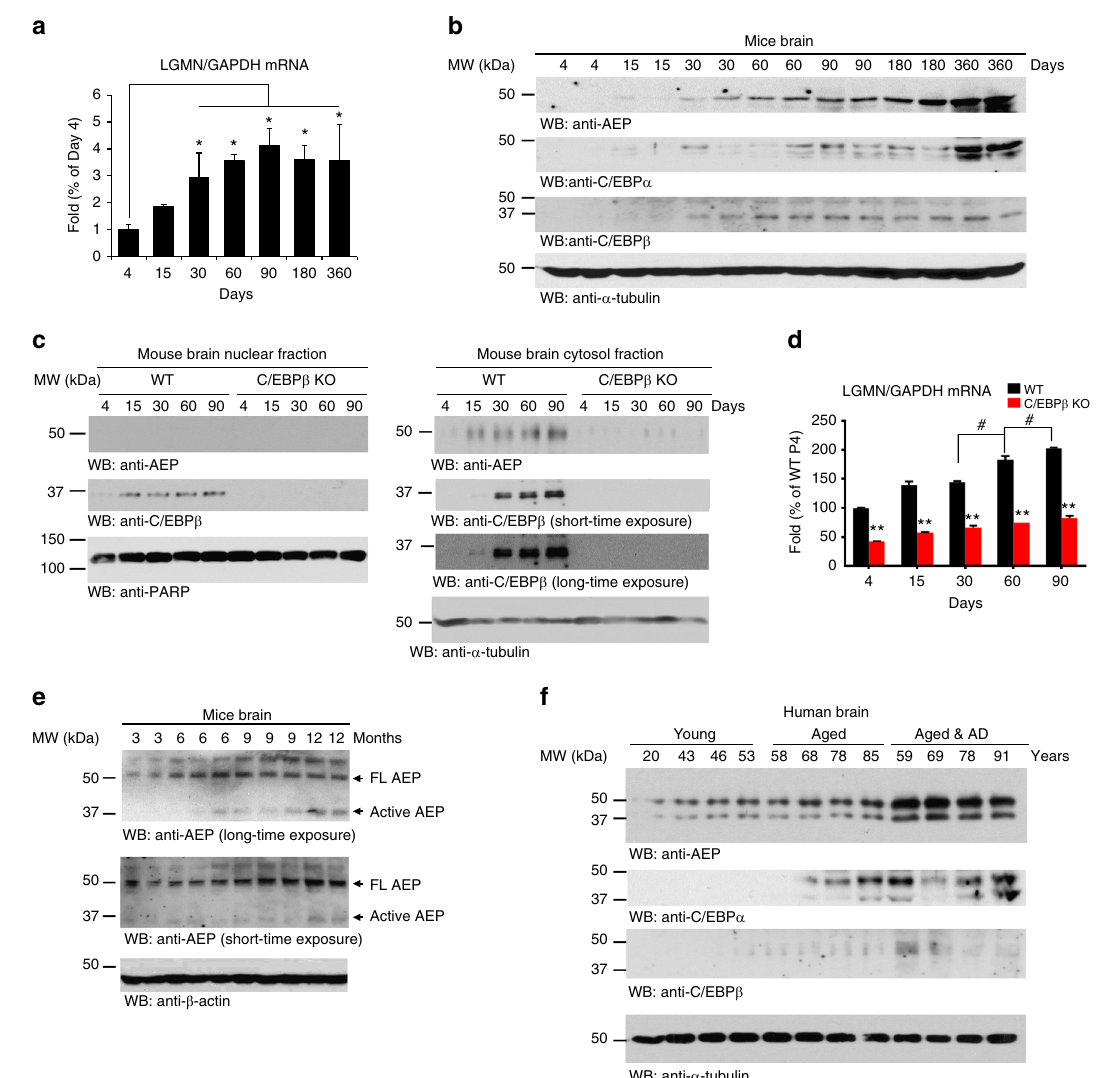
Fig. 3 The age-dependent increase of delta-secretase and C/EBPs. a , b Delta-secretase expression levels correlate with C/EBP β in mice. Different ages of C57BL/6 mice were analyzed by qRT-PCR and immunoblotting. Data in a represent mean ± s.e.m. of six mice per age; * P < 0.05, Student ’ s t -test. c , d Subcellular fractionation analysis of delta-secretase and C/EBP β in wild-type and C/EBP β -null mice. Different ages of wild-type and C/EBP β -de fi cient mice were sacri fi ced and their brains were subjected to subcellular fractionation to obtain the cytosolic and nuclear fractions. Delta-secretase protein ( c ) and mRNA ( d ) levels were analyzed by western blotting and real-time PCR. Delta-secretase predominantly resided in the cytosolic fractions, and depletion of C/EBP β diminished its expression ( c top panel). C/EBP β distributed in both fractions in an age-dependent manner ( c middle panel). Data in d represent mean ± s.e.m. of six mice per age (** P < 0.01 compared with age-matched WT, Student ’ s t -test; # P < 0.05 compared with 60-day-old C/EBP β KO mice, one-way ANOVA). e , f Delta-secretase increases with age in mouse and human brain. Delta-secretase was cleaved and activated age-dependently in mouse brains ( e ). The expression levels of C/EBP α and C/EBP β were also detected. The levels of these proteins were much more abundant in the brains of AD patients as compared to age-matched healthy controls ( f earlier onset of pathological defects in AD mouse models. The As expected, the concentrations of the cytokine IL-6, the major triple-transgenic model 3xTg AD mice (APPswe, PS1 M146V , Tau downstream effect of C/EBP β , were signi fi cantly higher in P301L) progressively develop plaques and tangles. Synaptic dys- 12 months old than in 2 months old AD mouse model brains function, including LTP de fi cits, manifests in an age-related man- (Fig. 4j). Together, these fi ndings support that C/EBP β plays an ner, but before plaque and tangle pathology (~12 months) 40 . To test essential role in mediating A β -induced delta-secretase expression our hypothesis, we injected lentivirus (LV) expressing C/EBP β into and its expression in AD mouse brains in an age-dependent way. the hippocampus of 3 months old 3xTg mice and age-matched wild-type mice (Supplementary Table 1). In addition, we also C/EBP β mediates AD-like pathogenesis via delta-secretase in injected AAV expressing a dominant-negative form of delta- 3xTg mice . Delta-secretase cleaves both APP and Tau in human effects in 3xTg mice. Overexpression of C/EBP β resulted in AD brains 2,3 and C/EBP β is increased in human AD brains 39 . We thus hypothesized that increased C/EBP β expression would aug- increased delta-secretase expression in wild-type mice that was ment delta-secretase transcription and protein levels, resulting in associated with increased levels of cleaved active delta-secretase as